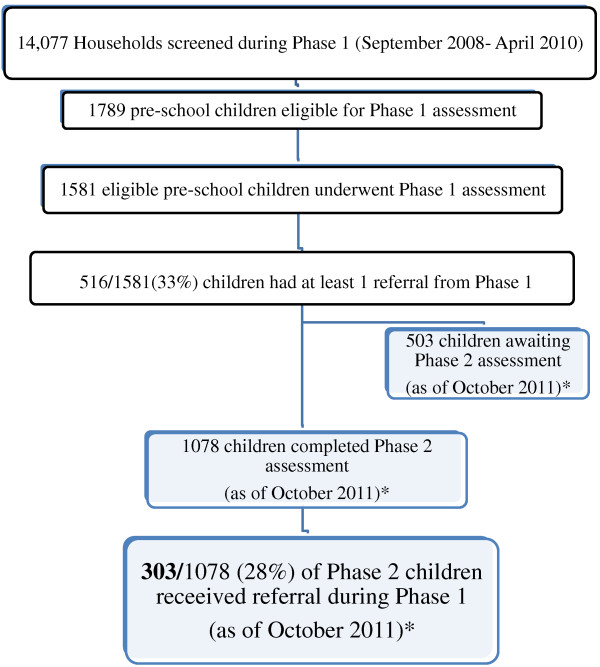
Children included in final analytic sample. *Phase 2 assessment still ongoing at the time of analysis.